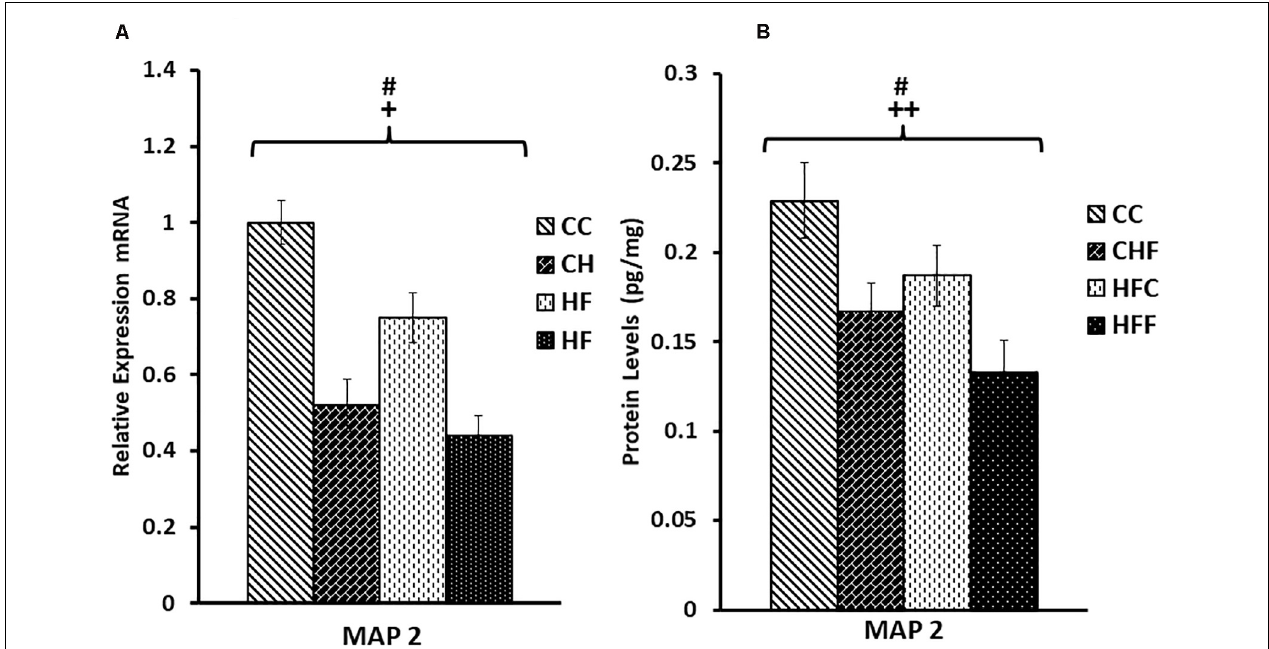
FIGURE 4 | Relative levels of MAP2 mRNA and protein expression in the hippocampus. (A) Using qRT-PCR, hippocampal microtubule-associated protein 2 (MAP2) mRNA expression was significantly reduced in response to the maternal diet ( F ( 3 , 57 ) = 3.28, P = 0.05) and post-weaning high-fat diets ( F ( 3 , 57 ) = 6.76, P = 0.013). Values are expressed in relative units where the CC group is set to 1. (B) Significant reductions in MAP2 protein levels (pg/mg) were also detected in response to both the maternal ( F ( 3 , 57 ) = 9.28, P = 0.004) and post-weaning HF diets ( F ( 3 , 57 ) = 5.67, P = 0.023) using ELISA. No significant interactions were detected using two-way ANOVA. Values are means + SEM ( n = 16 for each group). + P < 0.05, ++ P < 0.01 (significant maternal diet effect); # P < 0.05 (significant post-weaning diet